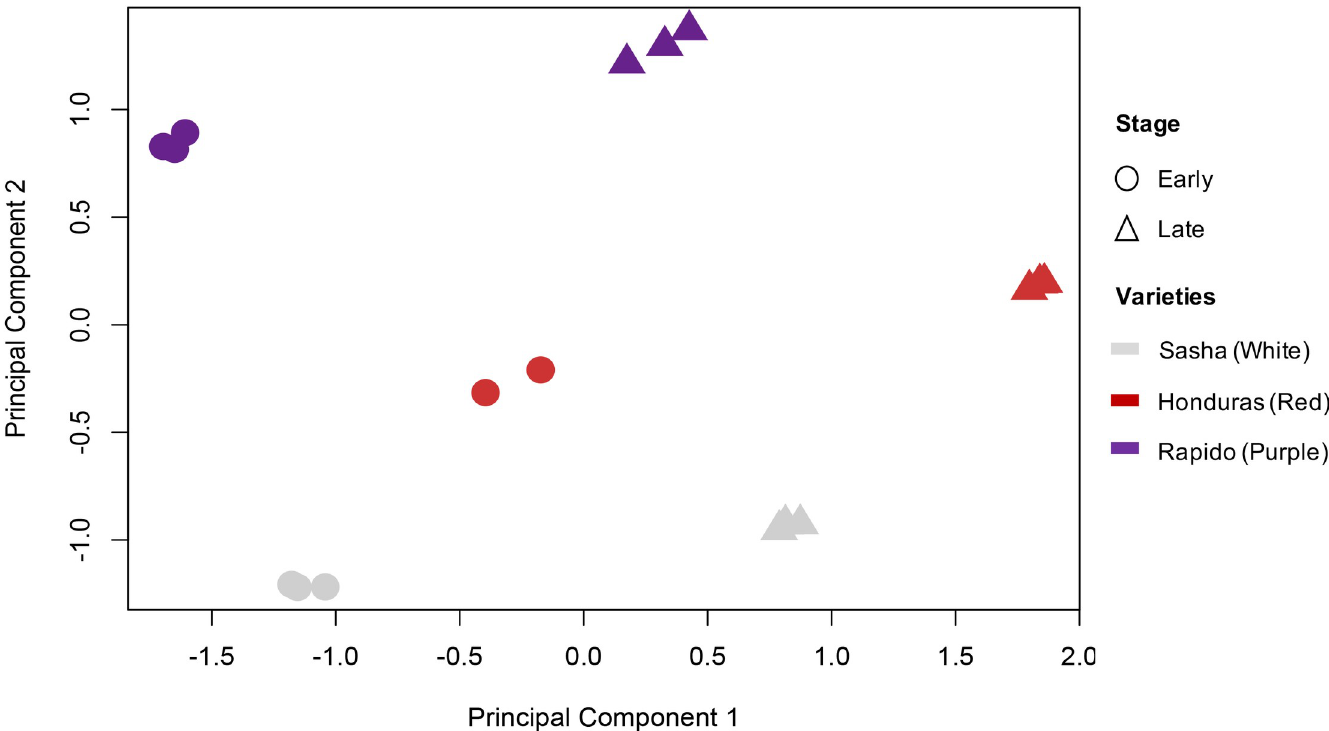
Fig 3. Multidimensional scaling based on gene expression. Samples on the negative scale of principal component 1 correspond to early developmental stages (circles) for either color, and samples on the positive side correspond to late developmental stages (triangles). Dispersion along principal component 2 explained variation between different colors: white (light grey), red (red), and purple (purple).